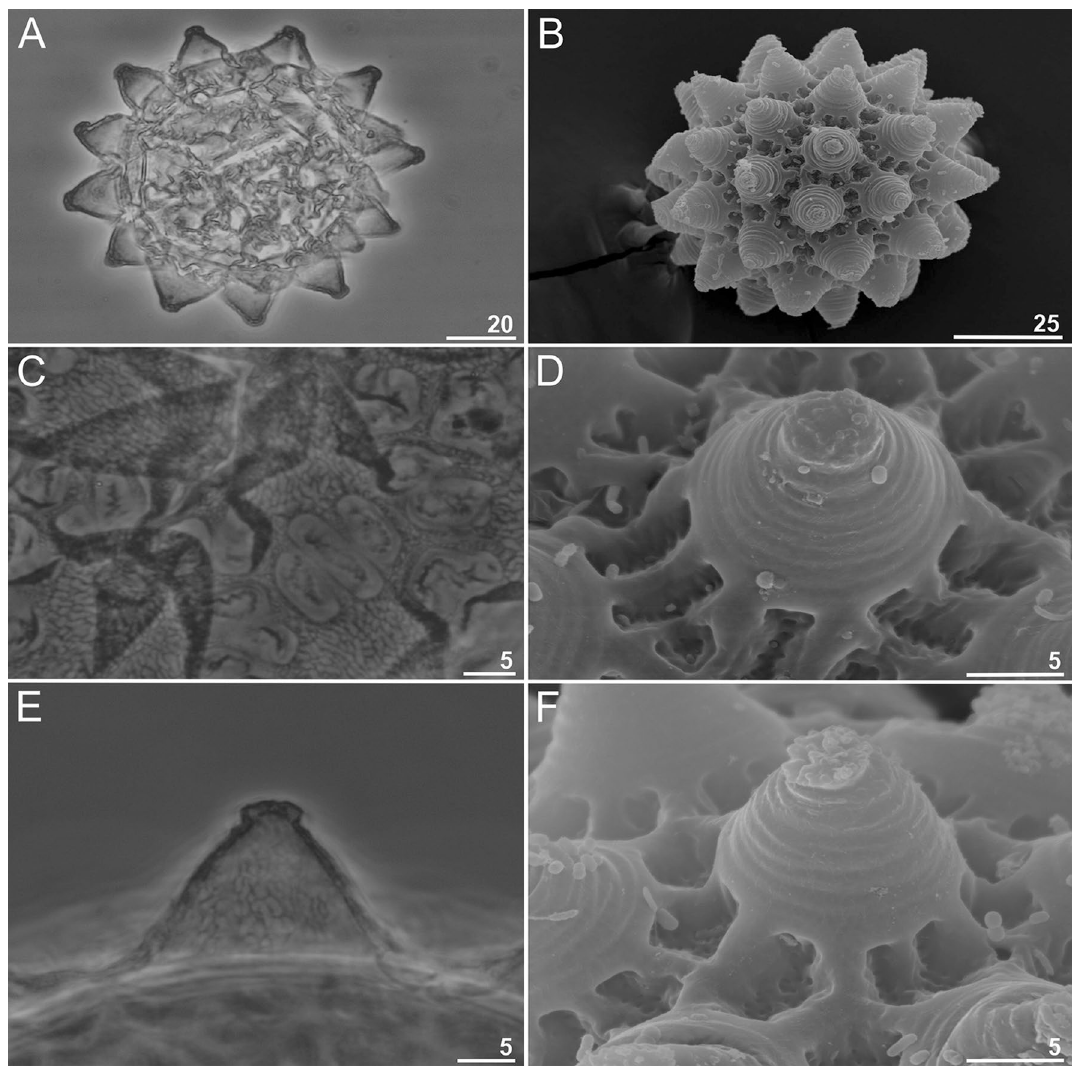
Figure 7. Paramacrobiotus gadabouti sp. nov.: eggs: ( A , B )—egg chorion (paratype, PCM and SEM respectively); ( C , D )—the surface between egg processes (paratype, PCM and SEM respectively); ( E , F )—egg processes (paratype, PCM and SEM respectively). Scale bars in